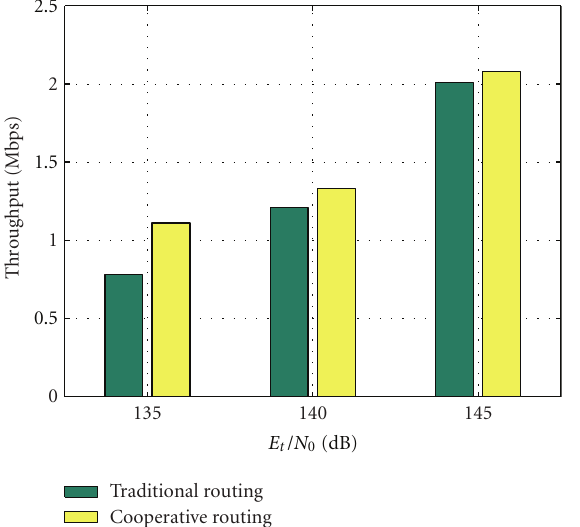
Figure 9: Traditional routing versus cooperative routing (through- put).